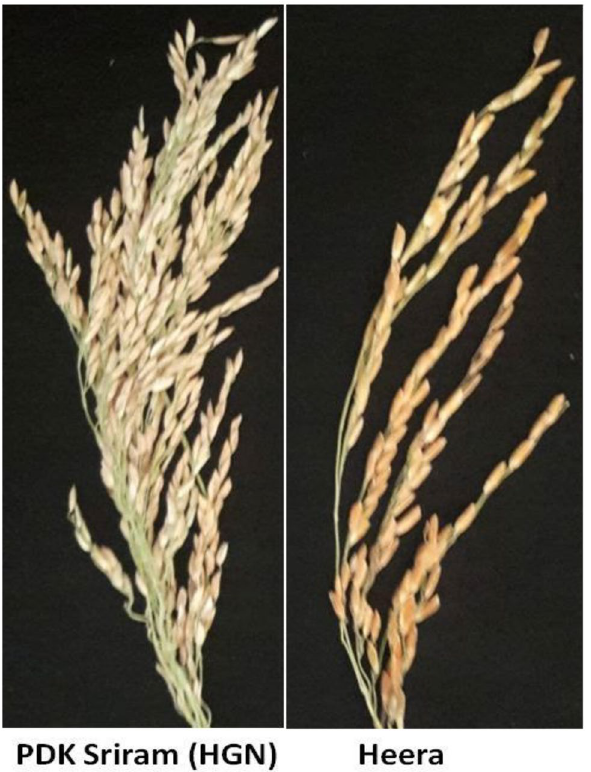
Figure 1. Parental rice cultivars PDK Shriram (HGN) and Heera showing compact- and lax-panicle type,